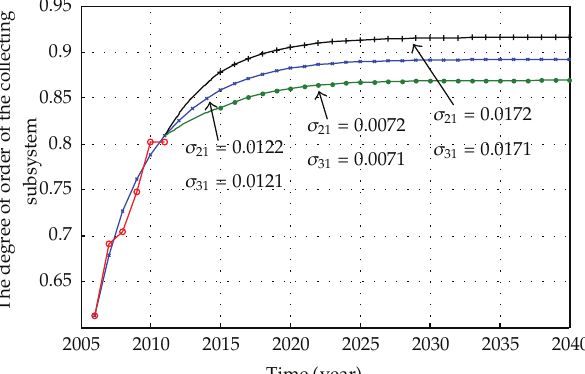
Figure 6: The ordered synergistic coevolution of the collecting subsystem with di ff erent synergistic coe ffi